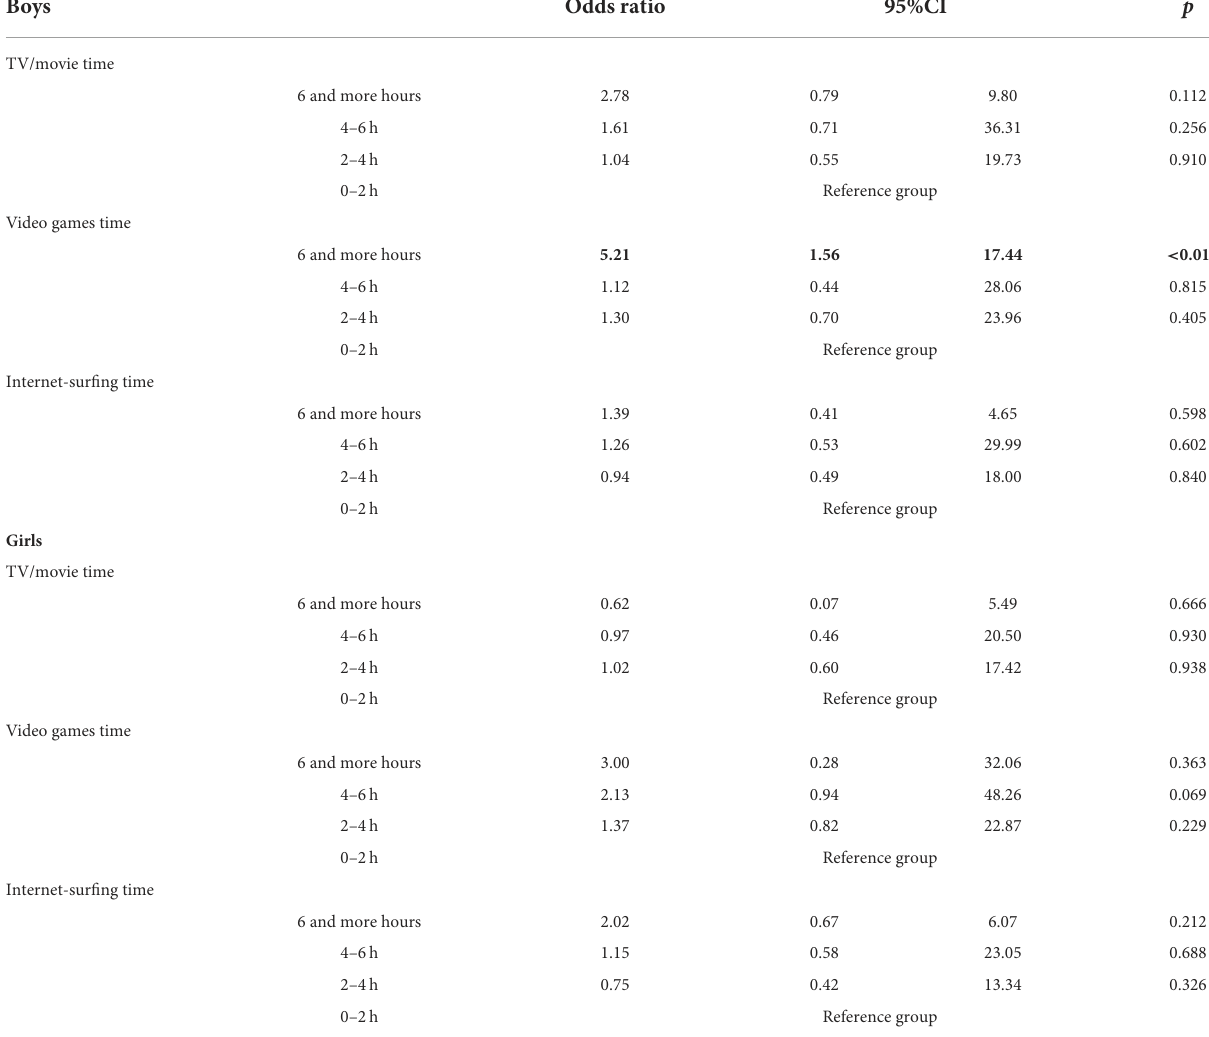
TABLE 3 Association between different types of sedentary-based behaviors and anxiety symptoms in the sample by sex. Boys Odds ratio 95%CI